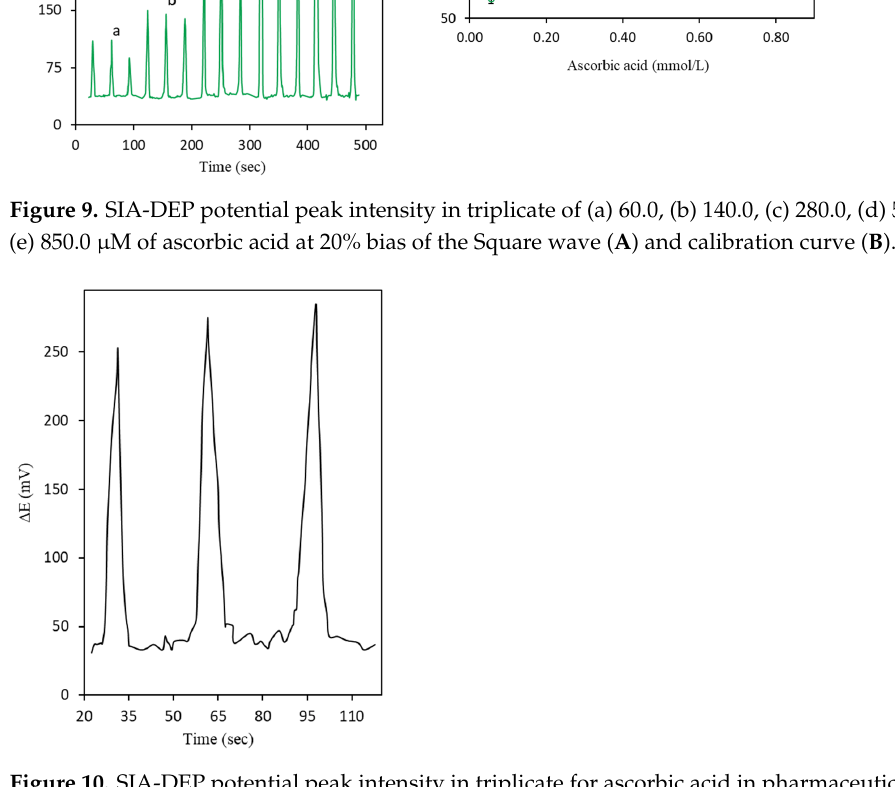
Figure 10. SIA-DEP potential peak intensity in triplicate for ascorbic acid in pharmaceutical sample (Redoxon) at the optimum conditions of square wave polarization mode.